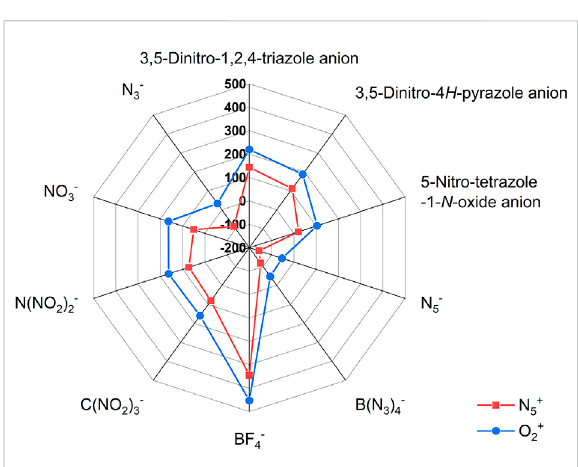
FIGURE 7 The radar plots of the effect of different anions on the Gibbs free energy change of the formation of the N 5 + and O 2 +